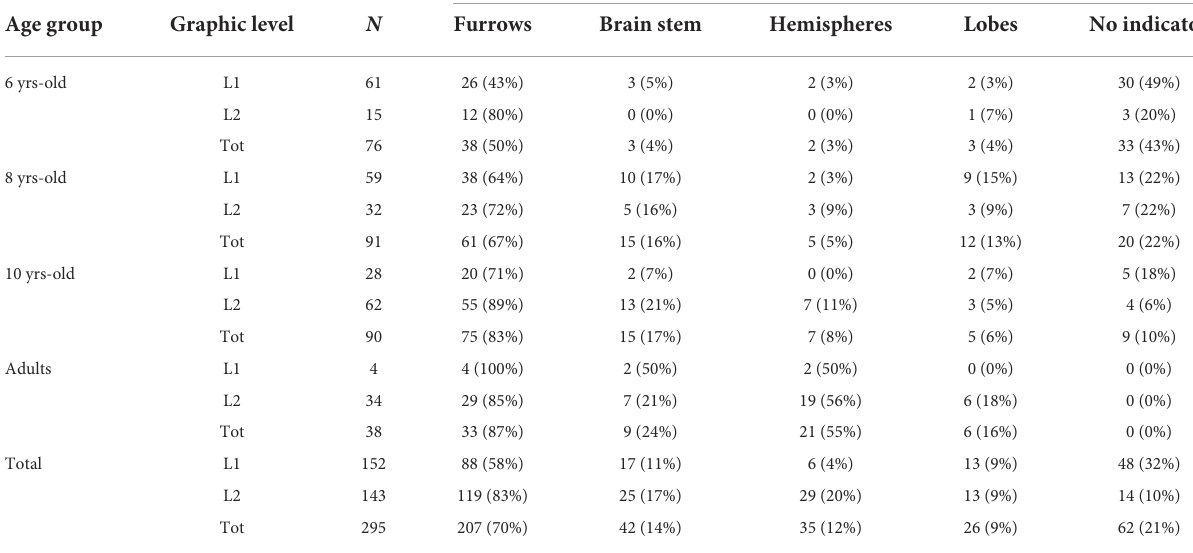
TABLE 1 Number (and percentages) of brain drawings depicting each type of graphic indicator as a function of age and graphic level (L1 = low graphic level and L2 = high graphic level).